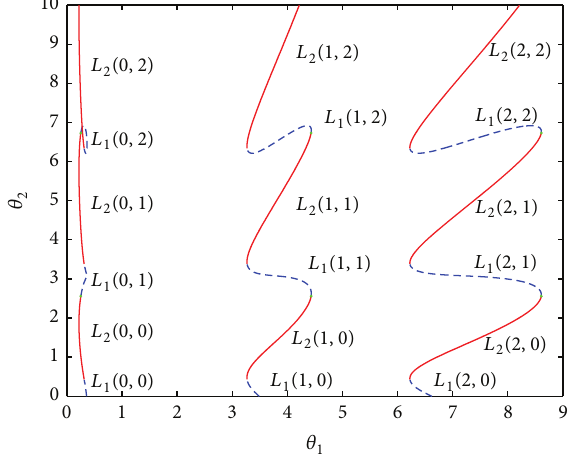
Figure 5: Crossing frequency Ω .